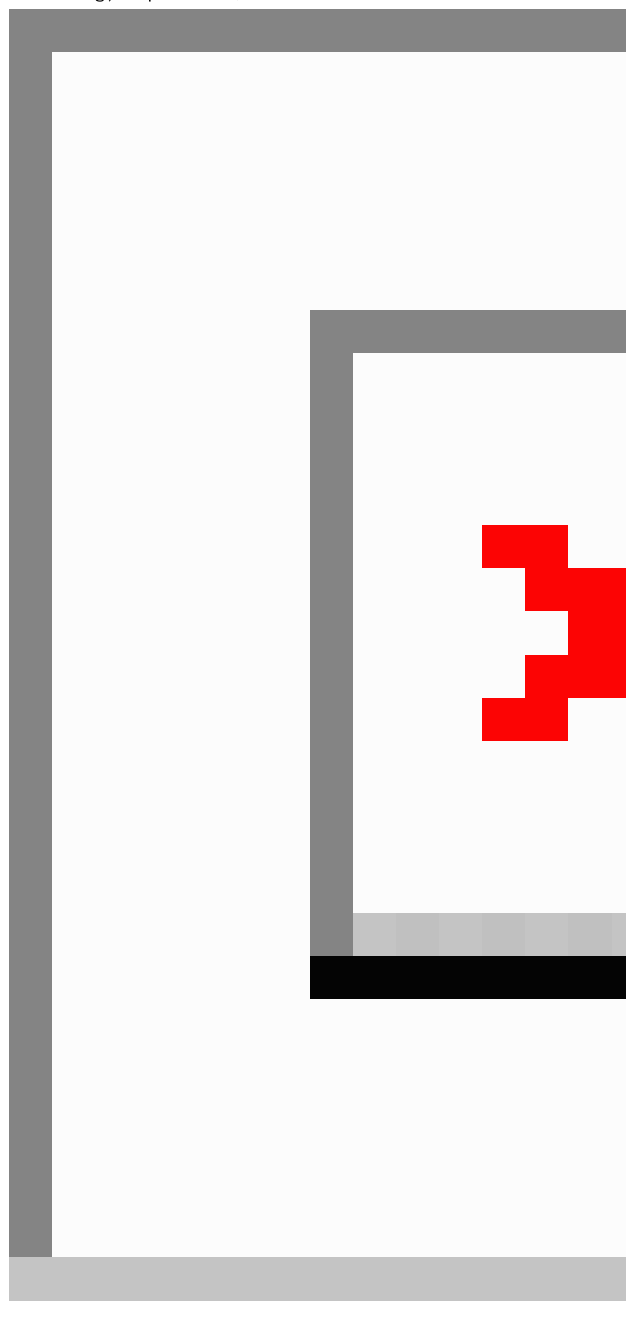
Figure 4. Median percent weight reduction at the end of the inpatient treatment and at 1-year follow-up (dropouts at follow-up are assumed to have regained 3.6 kg, 0.3 per